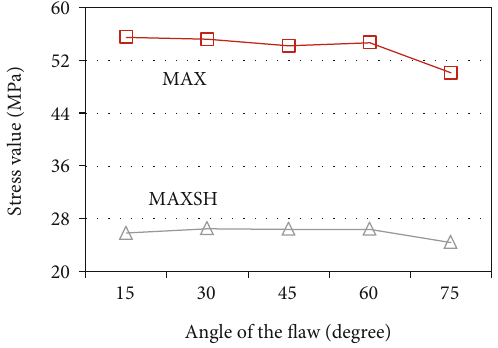
Figure 4: Evolution of the maximum principal stress.